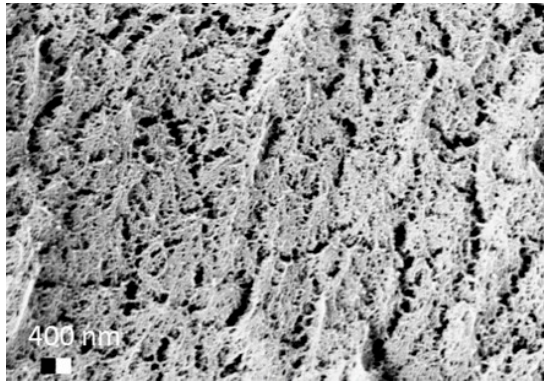
Figure 5. Inner structure of pure amidated pectin aerogel produced via the internal setting method.